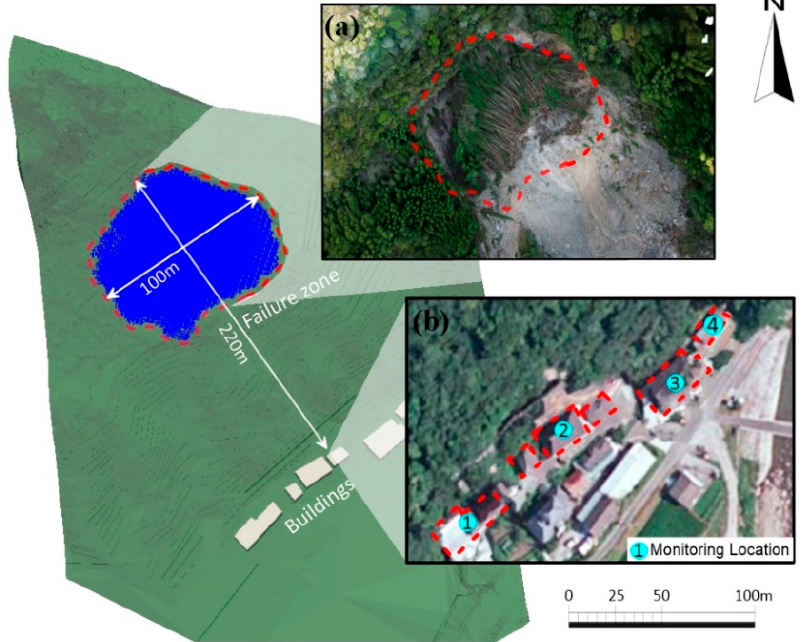
Figure 10. Initial configuration of the landslide model in the simulation. ( a ) Location of failure zone. ( b ) Location of monitoring points. Table 1. Influencing parameters and their values in the landslide simulation.